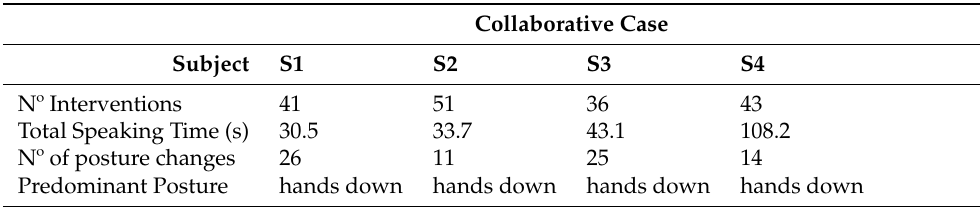
Table 3. Collaborative Activity Measurements.